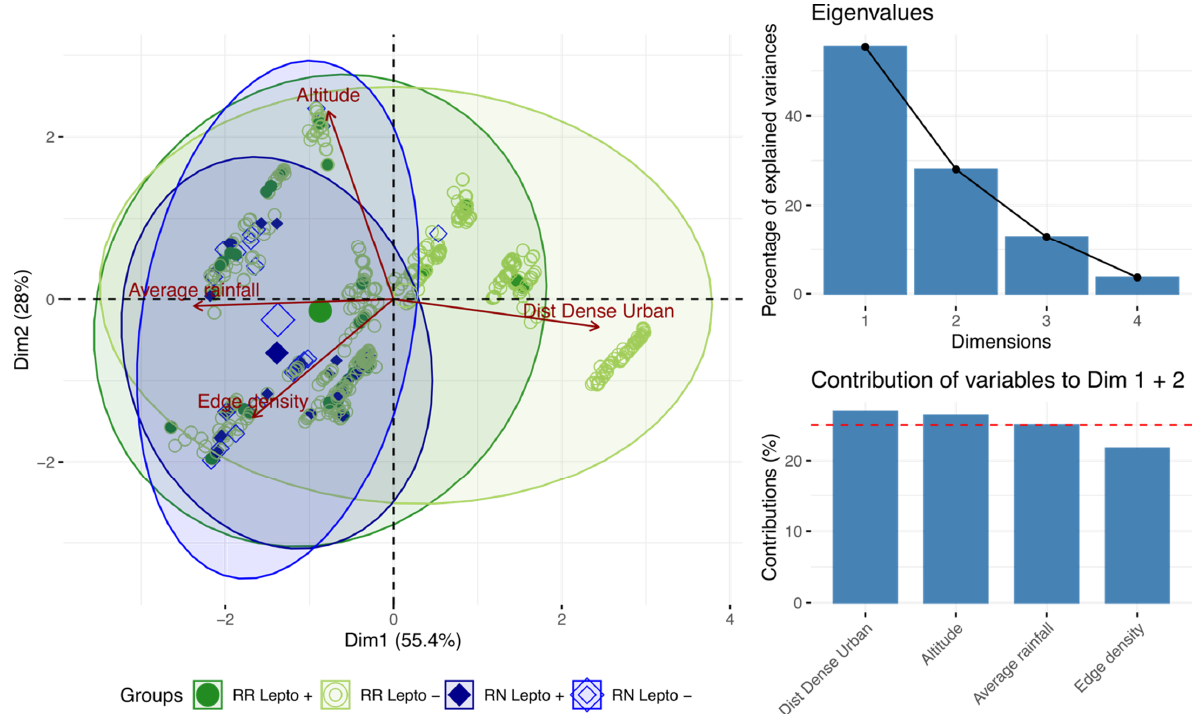
Figure 5. Principal component analysis showing the most discriminating variables. Table 3. Models obtained with logistic regressions to explain the carriage of leptospires (infected vs.